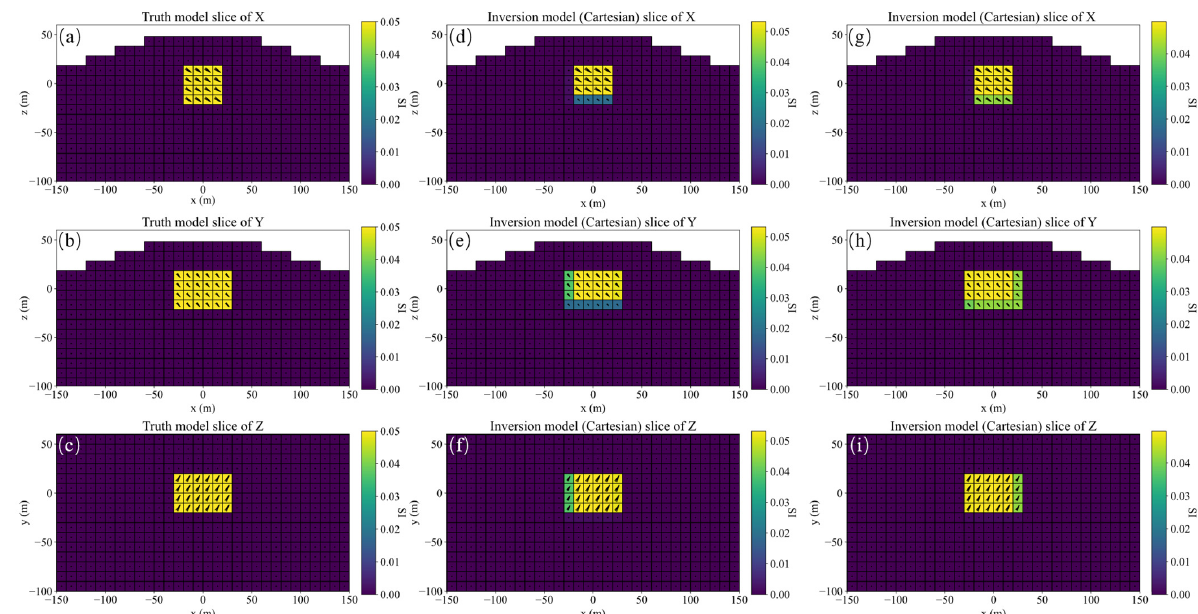
Figure 3. Slices in three Cartesian directions of the ground truth ( a – c ), inverted model 3 ( d – f ) and model 4 ( g – i ) under different data types of TMI and three-component magnetic field data, respectively.